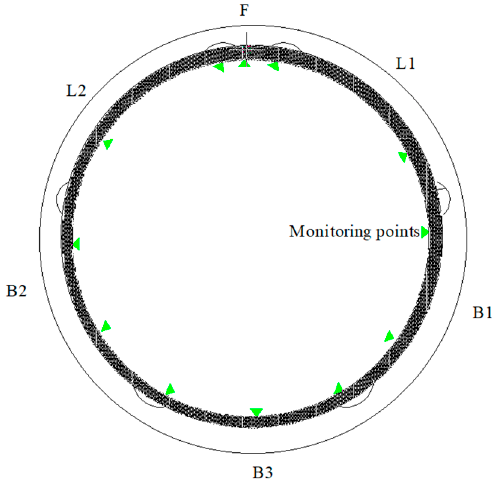
Figure 11. Monitoring-point arrangement